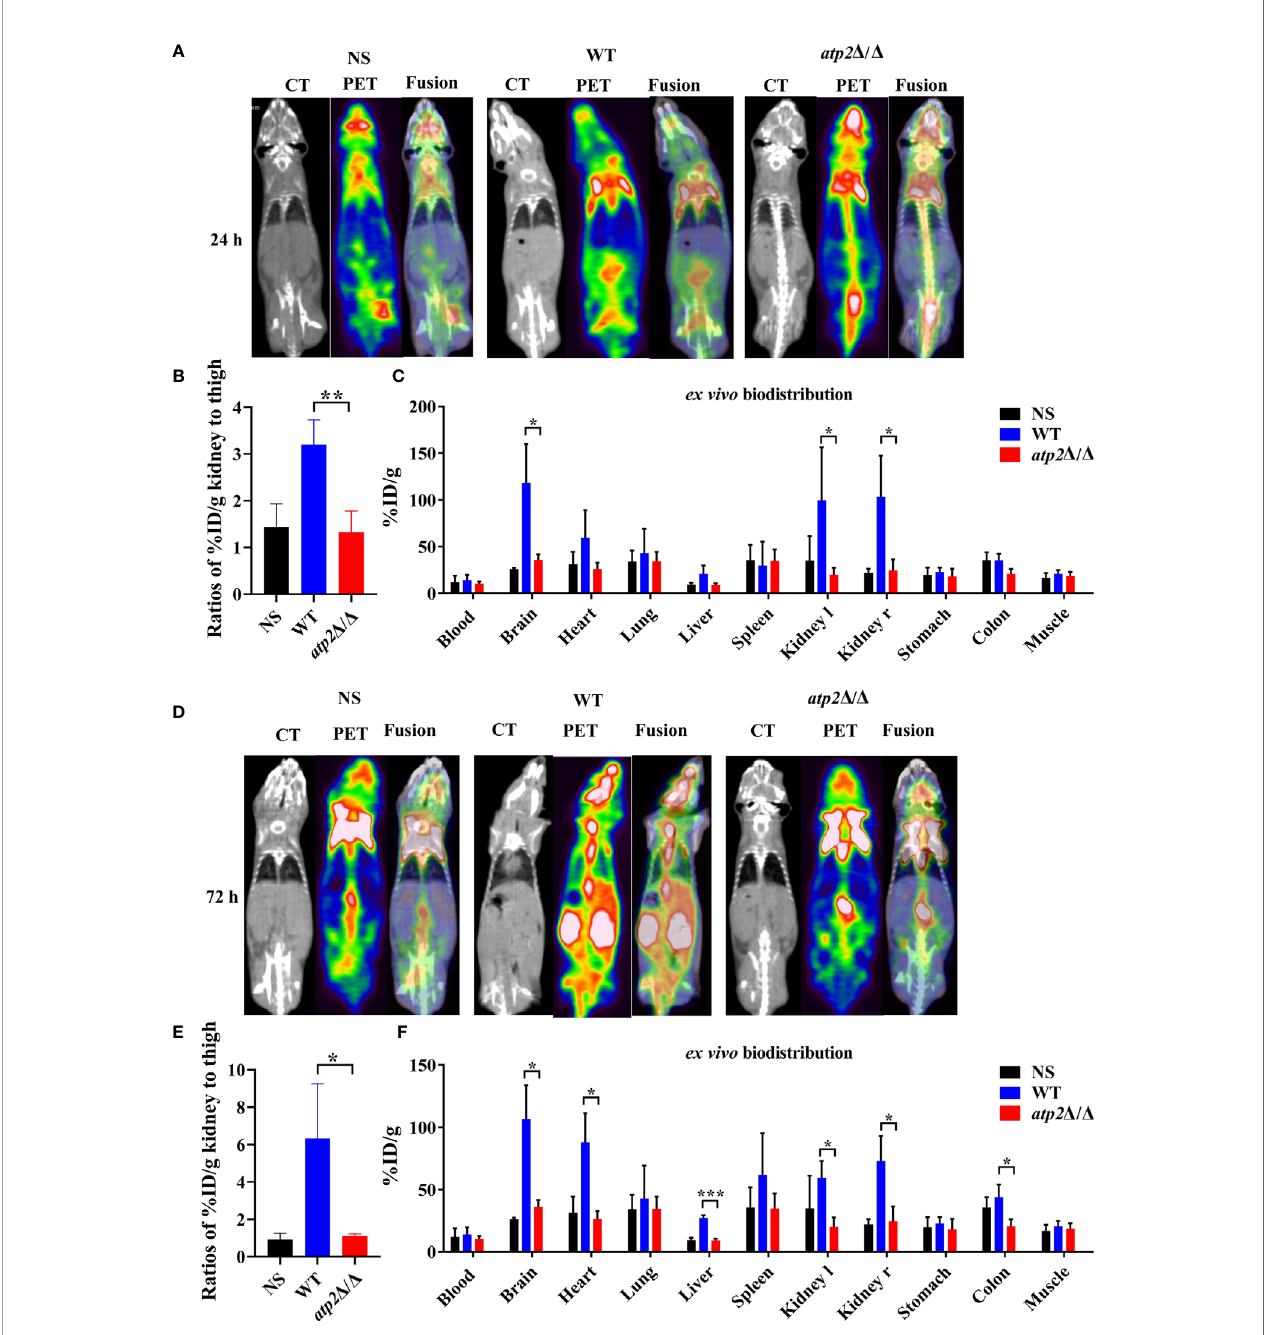
FIGURE 3 | ATP2 affects the activation of phagocytes by C. albicans in situ. (A, B) Representative CT, PET, and fusion images (A) and quantitative statistics of kidney signals from PET images (B) of mice ( n = 3) 24 h after systemic infection with NS, WT or atp2 D / D (2 × 10 5 CFU per mouse). (C) Ex vivo biodistribution in different tissues detected by g -counter immediately after micro-PET-CT examination of (A) . (D, E) Representative CT, PET, and fusion images (D) and quantitative statistics of kidney signals from PET images (E) of mice 72 h after systemic infection. (F) Ex vivo biodistribution in different tissues detected by g -counter immediately after microPET/CT examination of (E) . In (A, D) , one representative experiment of three independent experiments is shown. In (B, C, E, F) , data are shown as mean ± s.d. * P< 0.05, ** P <0.01, *** P <0.001; by Student ’ s t